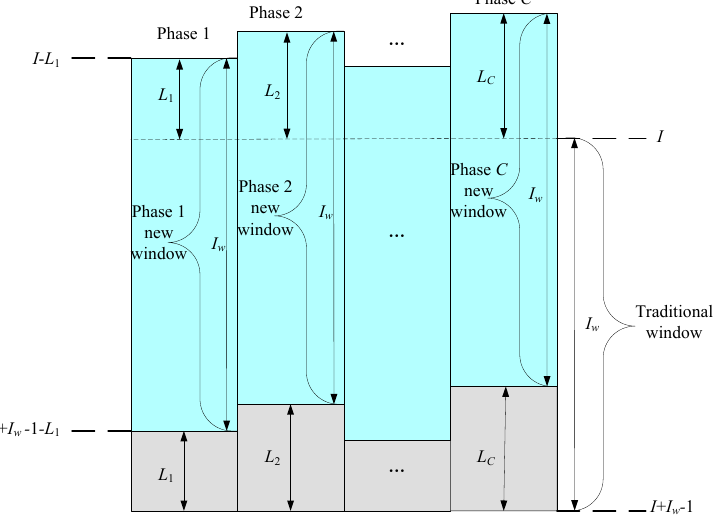
Figure 2. Development of sliding window with augmented batches.